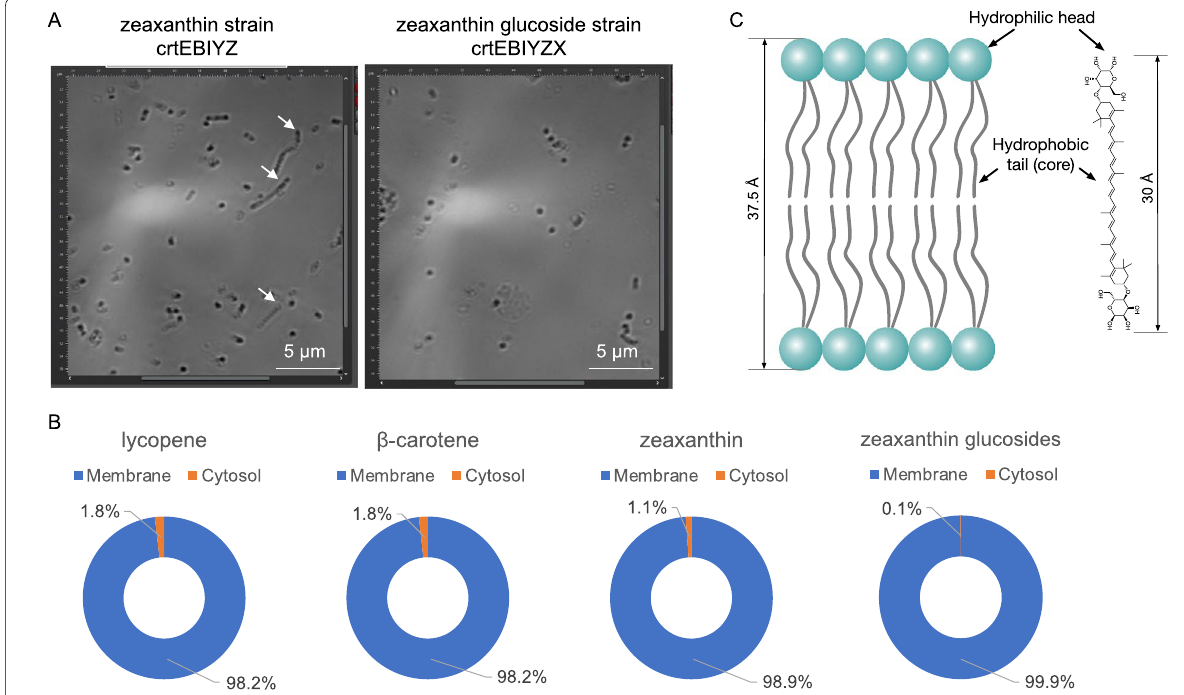
Fig. 5 Structural similarity between membrane and carotenoid diglucosides and its biological benefits. A Comparison between zeaxanthin and zeaxanthin glucosides strains. B Carotenoid distribution between cytosol and membrane. C Structural similarity between phospholipid bilayers and zeaxanthin diglucoside and their